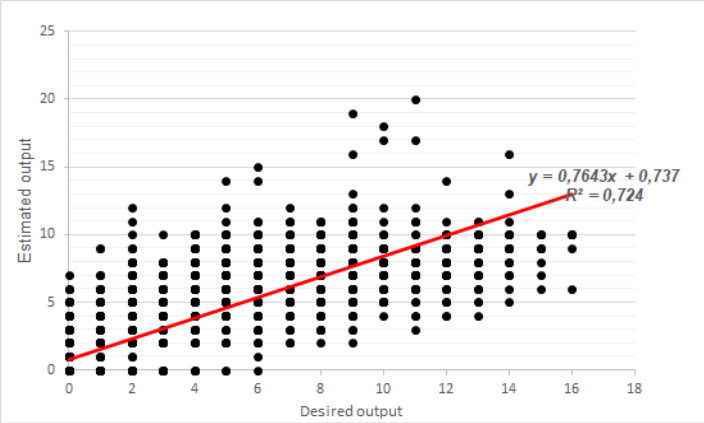
Figure 10. R 2 graphical interpretation when the data set is unfiltered.